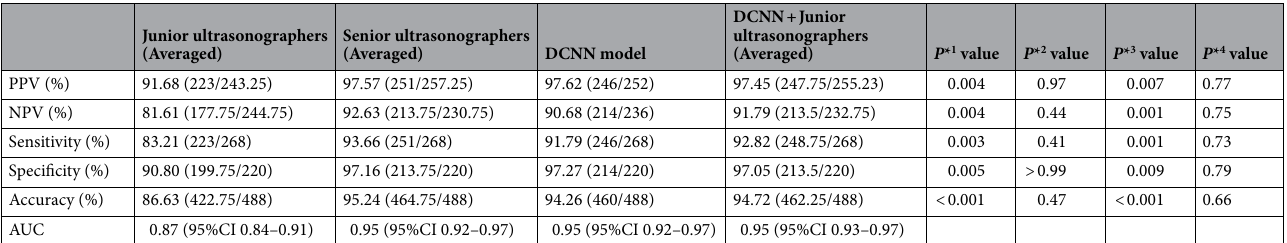
Table 4. Comparison between the DCNN model and ultrasonographers with different levels of seniority. PPV positive predictive value, NPV negative predictive value, AUC area under the receiver operating characteristic curve. P* 1 value for Junior ultrasonographers (Averaged) compared to DCNN. P* 2 value for Senior ultrasonographers (Averaged) compared to DCNN. P* 3 value for DCNN + Junior ultrasonographers (Averaged) compared to Junior ultrasonographers (Averaged). P* 4 value for DCNN + Junior ultrasonographers (Averaged) compared to Senior ultrasonographers